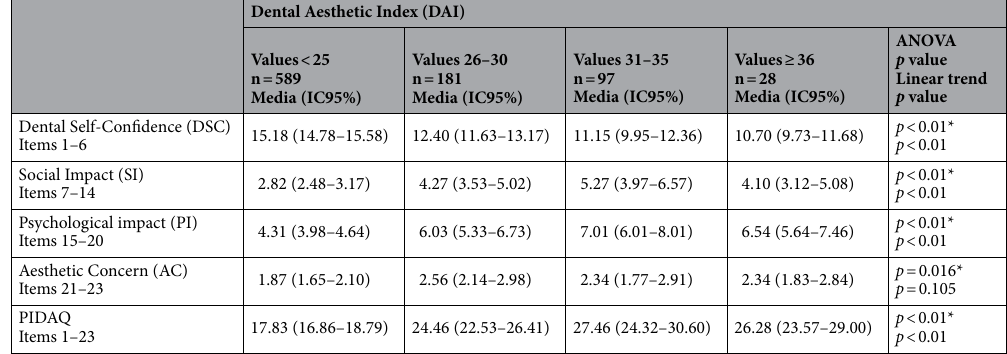
Table 2. PIDAQ means for each grade of treatment need according to DAI (CI 95%) and ANOVA contrasts of means. * p value < 0.05. Post Hoc Bonferroni. Statistical significance between groups: 1 versus 2, 3 and 4.